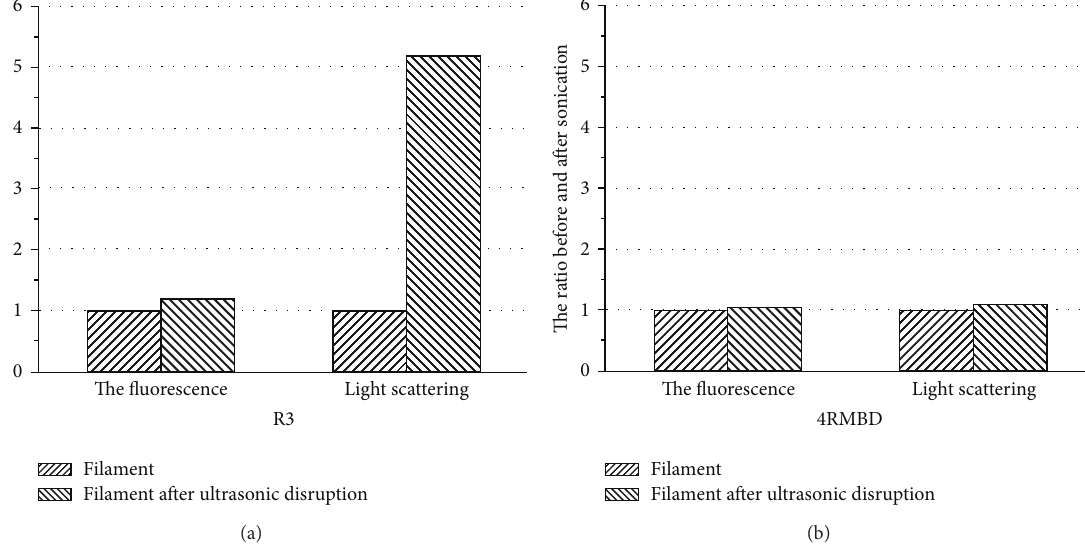
Figure 5: The effect of ultrasonication on light scattering (right side) and ThS fluorescence (left side) of R3 and 4RMBD before ( ≡ ) and after (///)